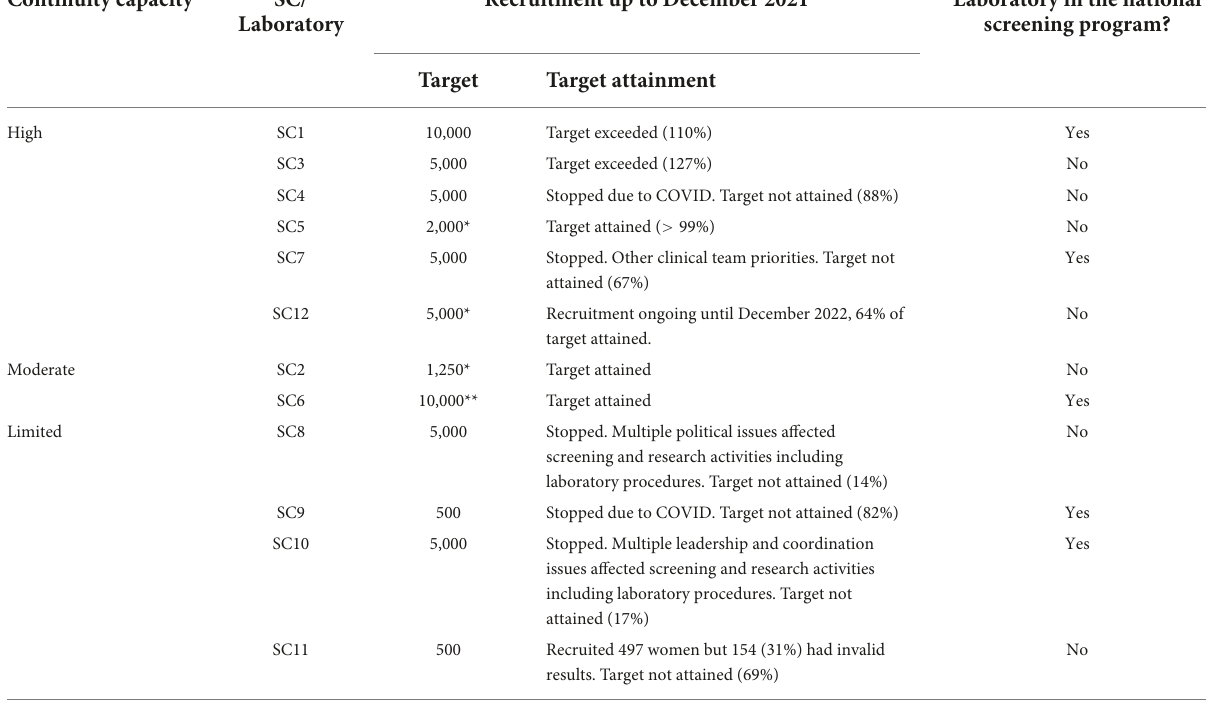
SC:studycenter.SC/Laboratory:laboratoryperformingHPVtestingforeachSC.